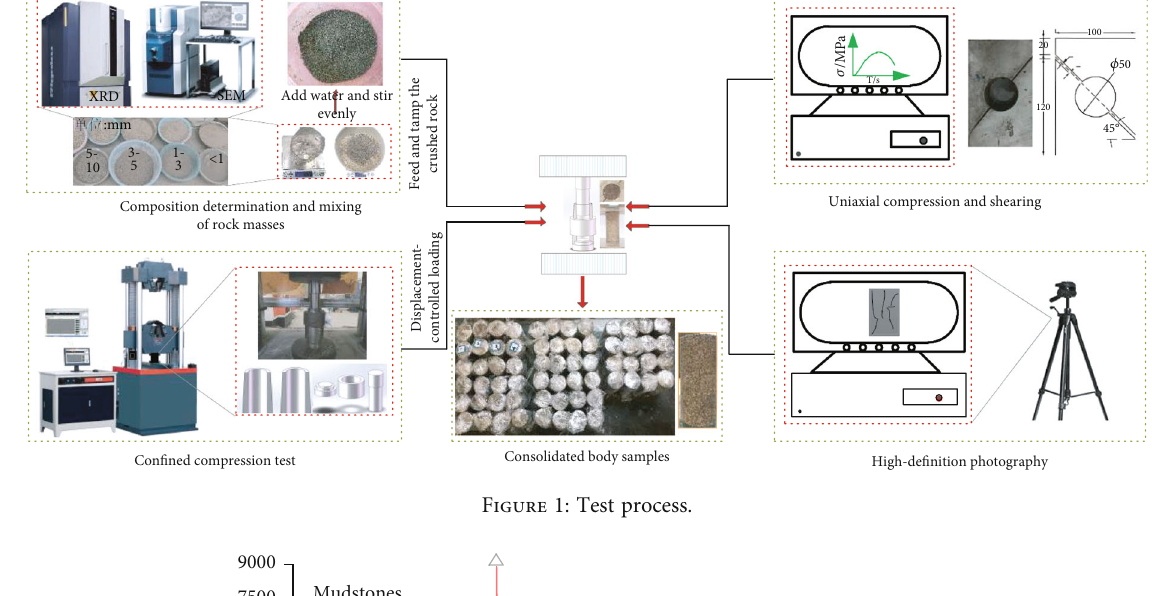
Figure 1: Test process.